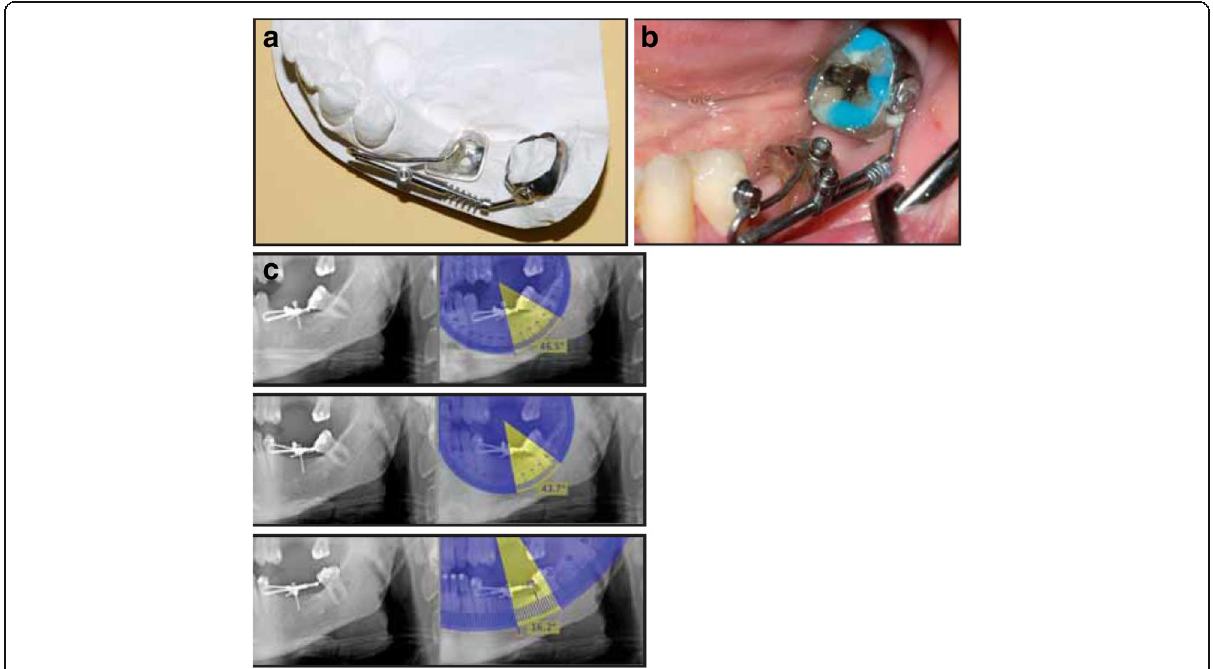
Fig. 8 Uprighting of mesially inclined #37 with a modified Uprighter Jet. a Uprighter Screw consists of a molar band with a welded lingual button that allows crown rotation when a force is applied; a .036 in. tube positioned parallel to the occlusal plane; a wire with a bayonet bend on the mesial end, curving back distally from the tube, and a loop on the distal end that is screwed to the molar band; an adjustable screw clamp; and a 150-g nickel titanium open coil spring. b After 2 months of uprighting. c Radiographs with Uprighter Screw in place. a At the time of appliance insertion, showing 46.5° inclination of the second molar ʼ s long axis relative to miniscrew. b After 2 months of uprighting, showing 43.7° inclination. c After 5 months of